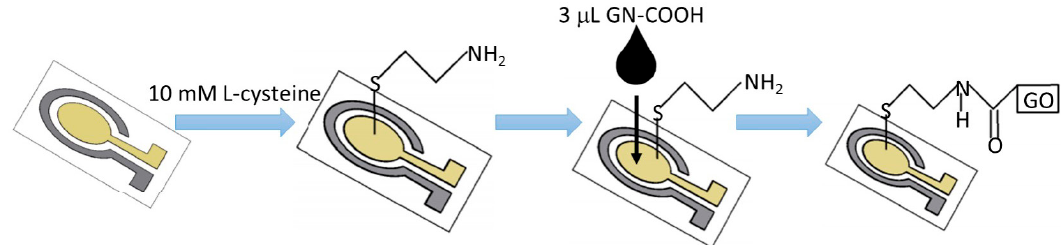
Figure 1. Schematic drawing of the Gr/ L -cysteine nanocomposite self-assembly process.